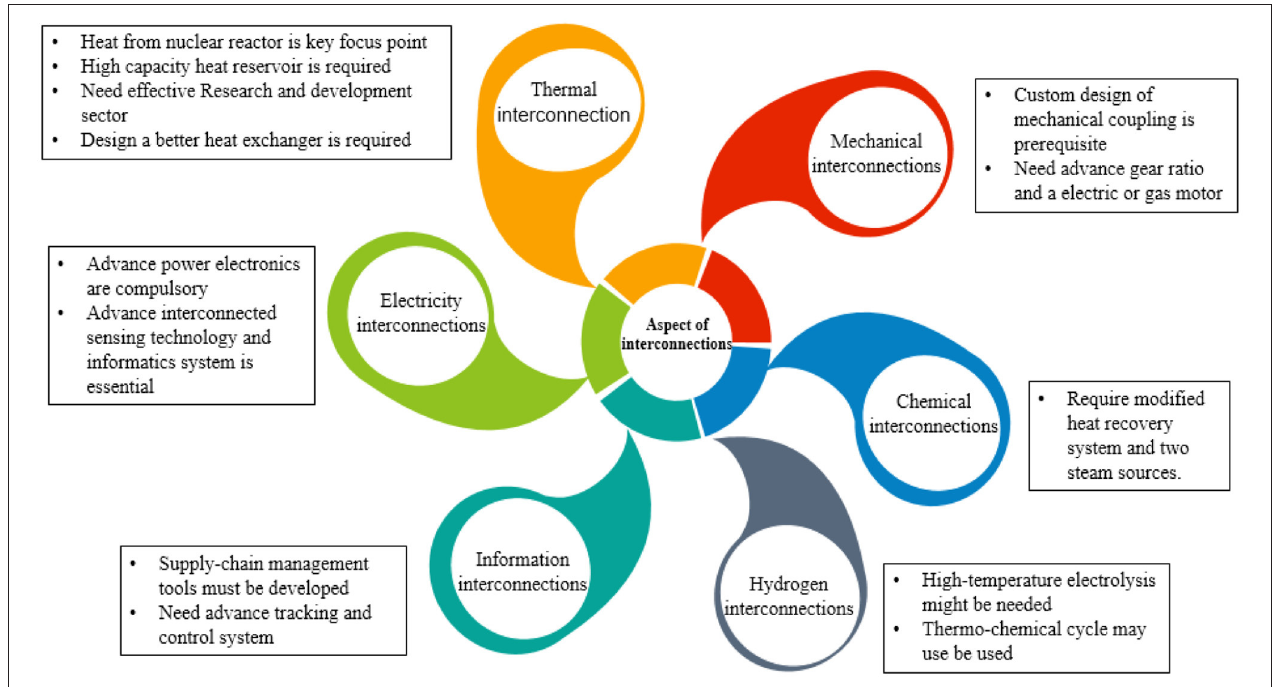
FIGURE 4 | Six interconnections pathway for nuclear-renewable hybrid system.